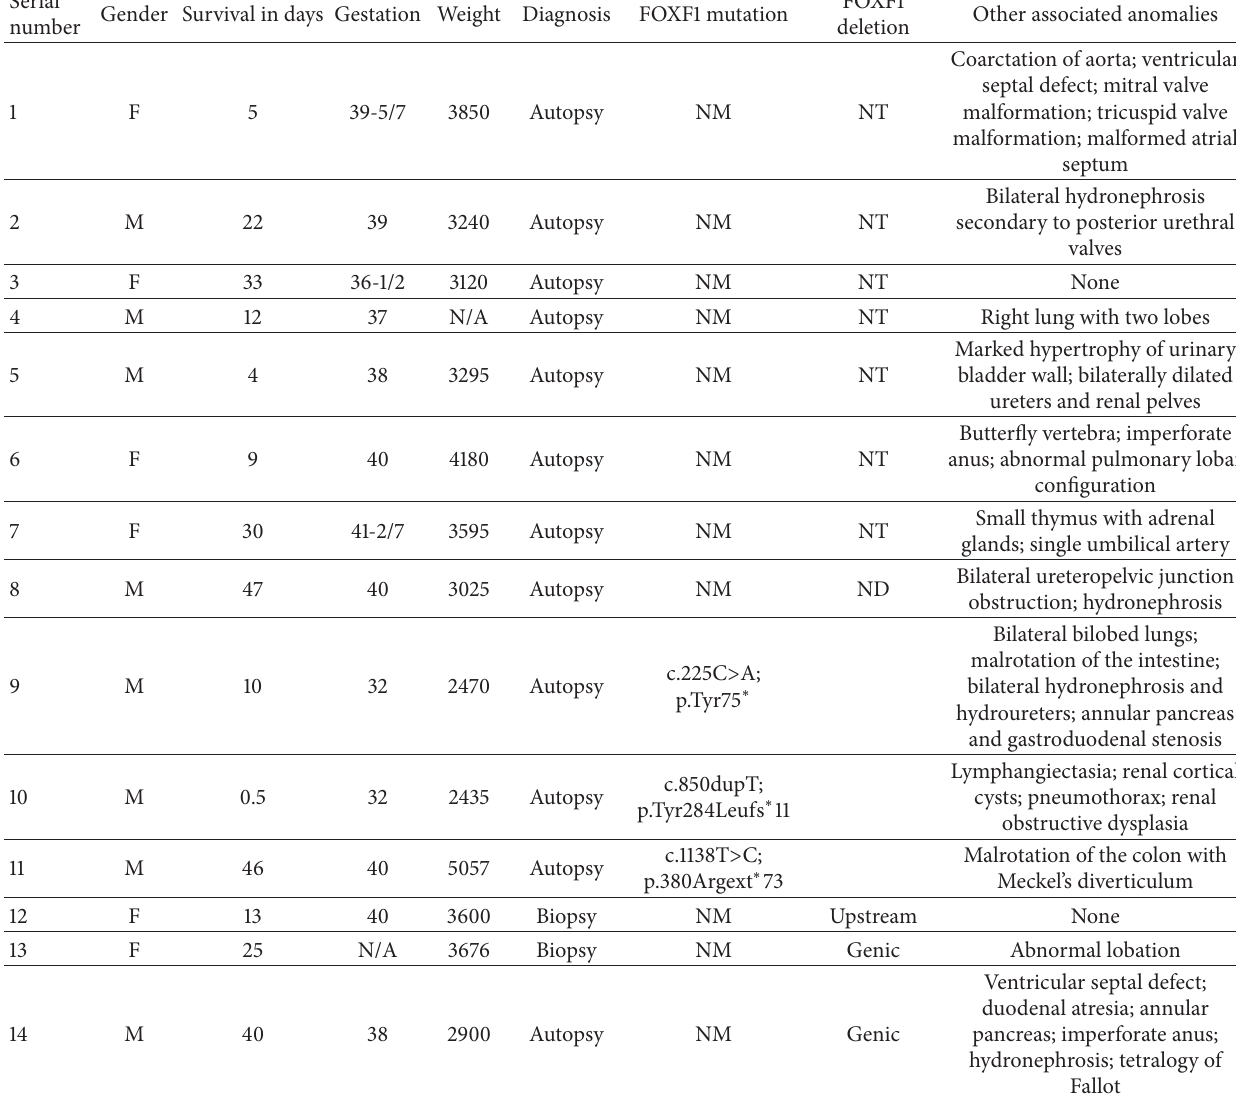
Table 1: ACD/MVP patient population with testing for mutation and/or deletions in FOXF1 . Cases not tested for deletions typically had fragmented and/or poorly preserved DNA making testing